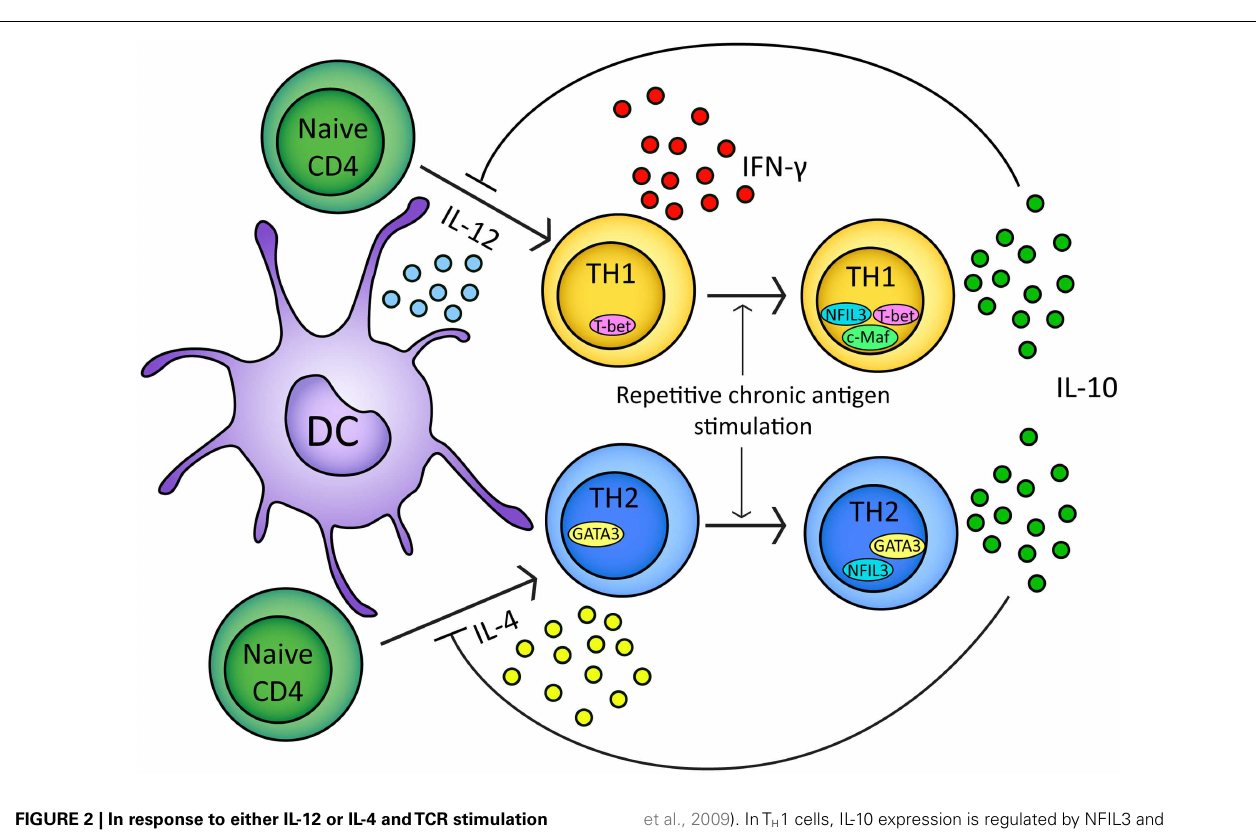
FIGURE 2 | In response to either IL-12 or IL-4 andTCR stimulation naïve CD4 + T cells will upregulateT-bet or GATA3 transcription factors respectively . Differentiation of naïve CD4 + t cells intoT H 1/T H 2 lineages is based onT-bet/GATA3 transcription factor expression (Ouyang et al., 2000; Lucas et al., 2003). Upon repeated chronicTCR stimulationT H 1 andT H 2 cells express IL-10 (Gabryšová et al., 2009; Xu